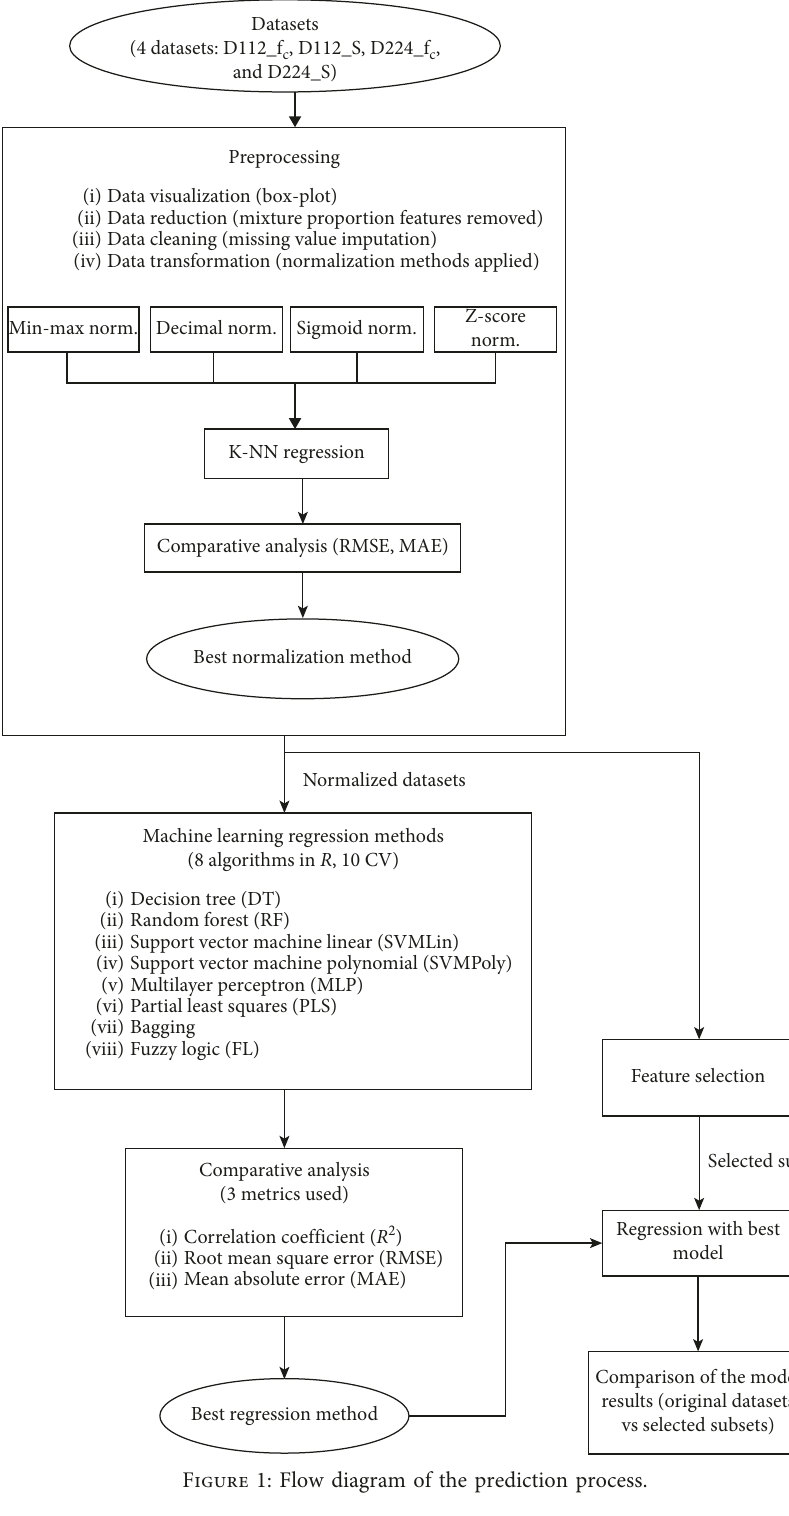
Figure 1: Flow diagram of the prediction